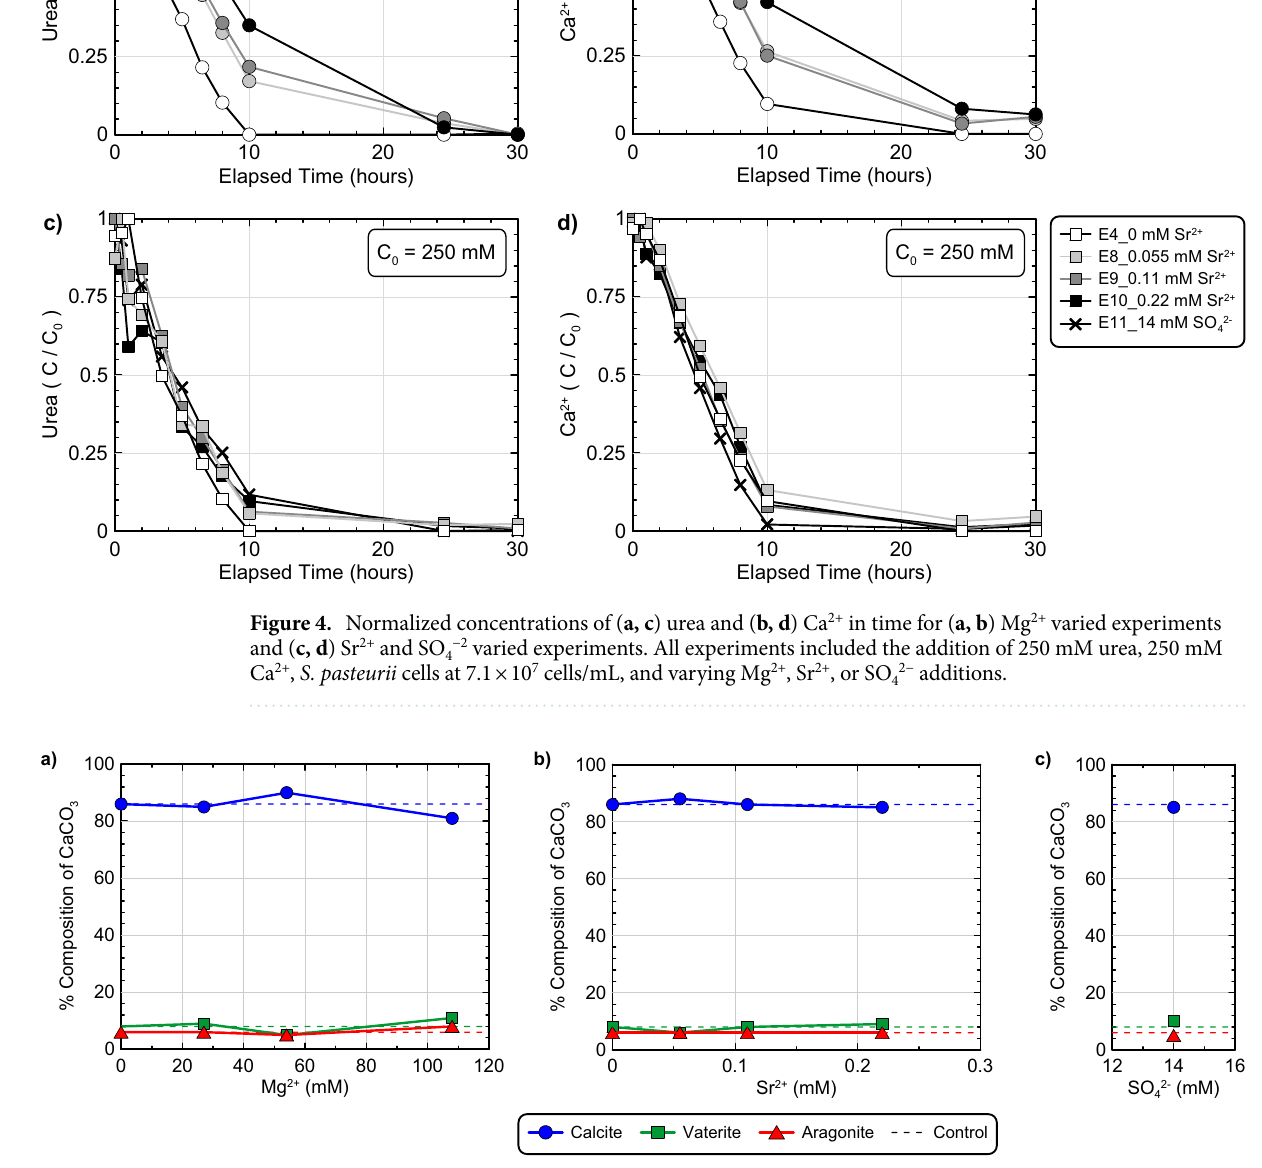
Figure 5. Relative CaCO 3 mineral content percentages for ( a ) Mg 2+ varied experiments, ( b ) Sr 2+ varied experiments, and the ( c ) 14 mM SO 42− experiment determined from S-Q analysis of XRD diffraction